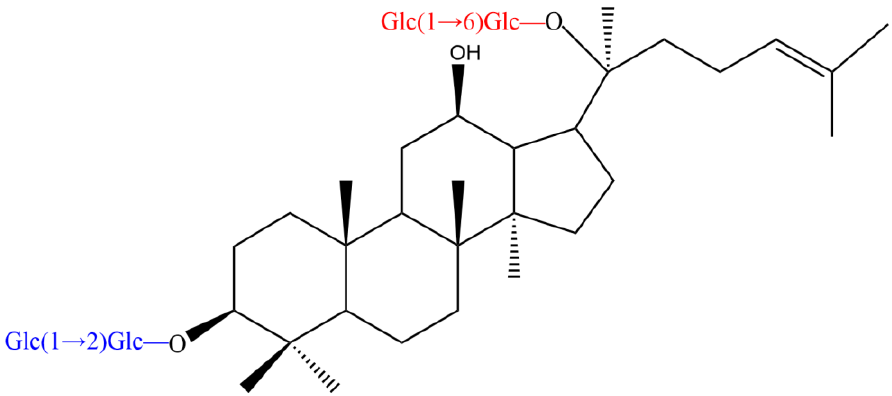
Figure 3. Chemical structure of ginsenoside Rb1. The chemical structure was drawn by the ChemDraw software. Table 1. Chemical structures of PPD-type ginsenosides.